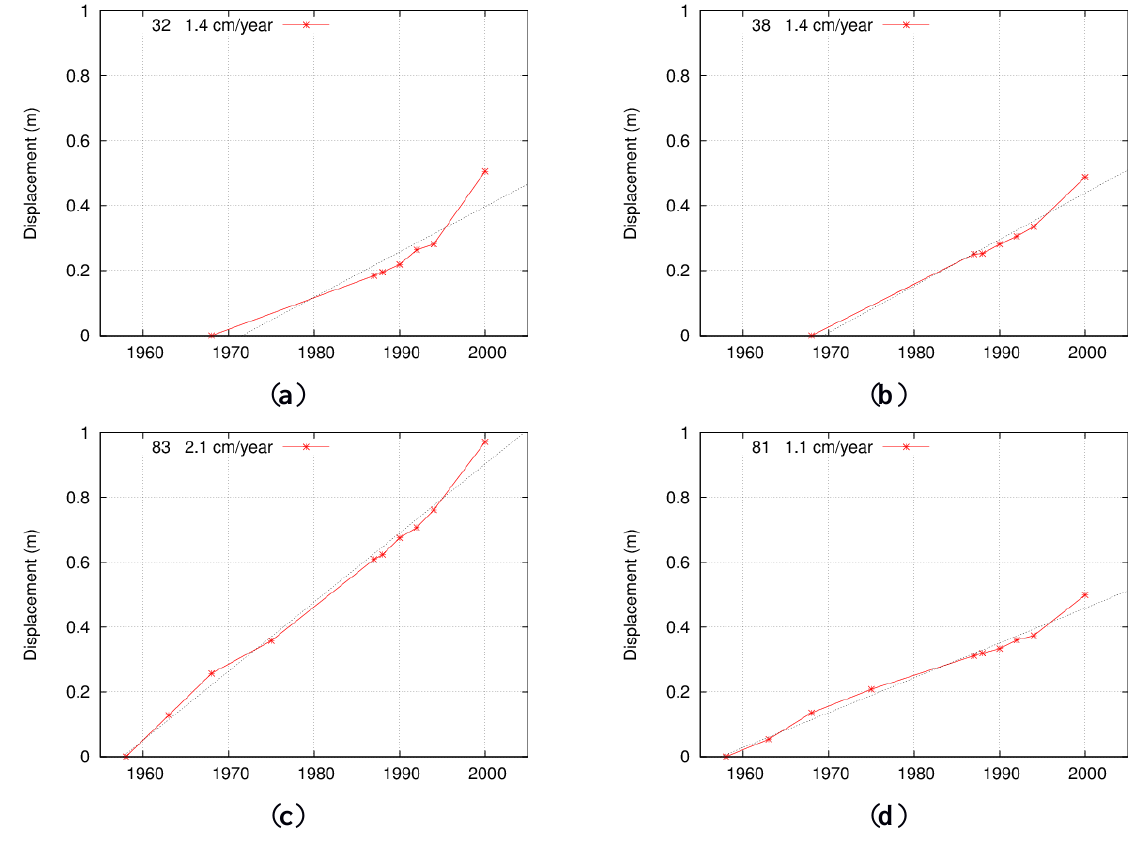
Figure 8. Time series of ground motion from geodetic classical trigonometric techniques for selected benchmarks with average displacement rate shown by a dotted line. The geographical location of the benchmark points is indicated in Figure 4. ( a ) Benchmark #